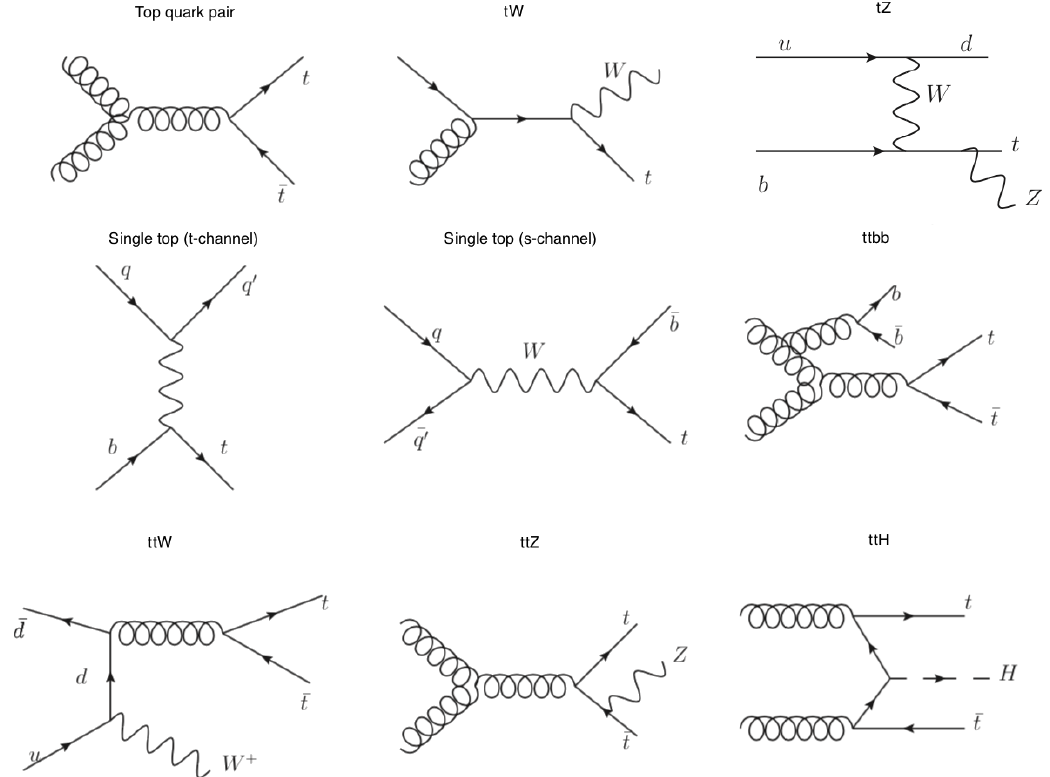
Figure 1 . Representative Feynman diagrams at the Born level for the dominant production chan- nels of top quarks at the LHC that are considered in the present SMEFT analysis. We show top-quark pair production; single-top production in association with a W or Z boson and in the t - and s -channels; t (cid:22) t production in association with t (cid:22) t or b (cid:22) b ; and t (cid:22) t production in association with a W or Z gauge boson or with the Higgs boson H